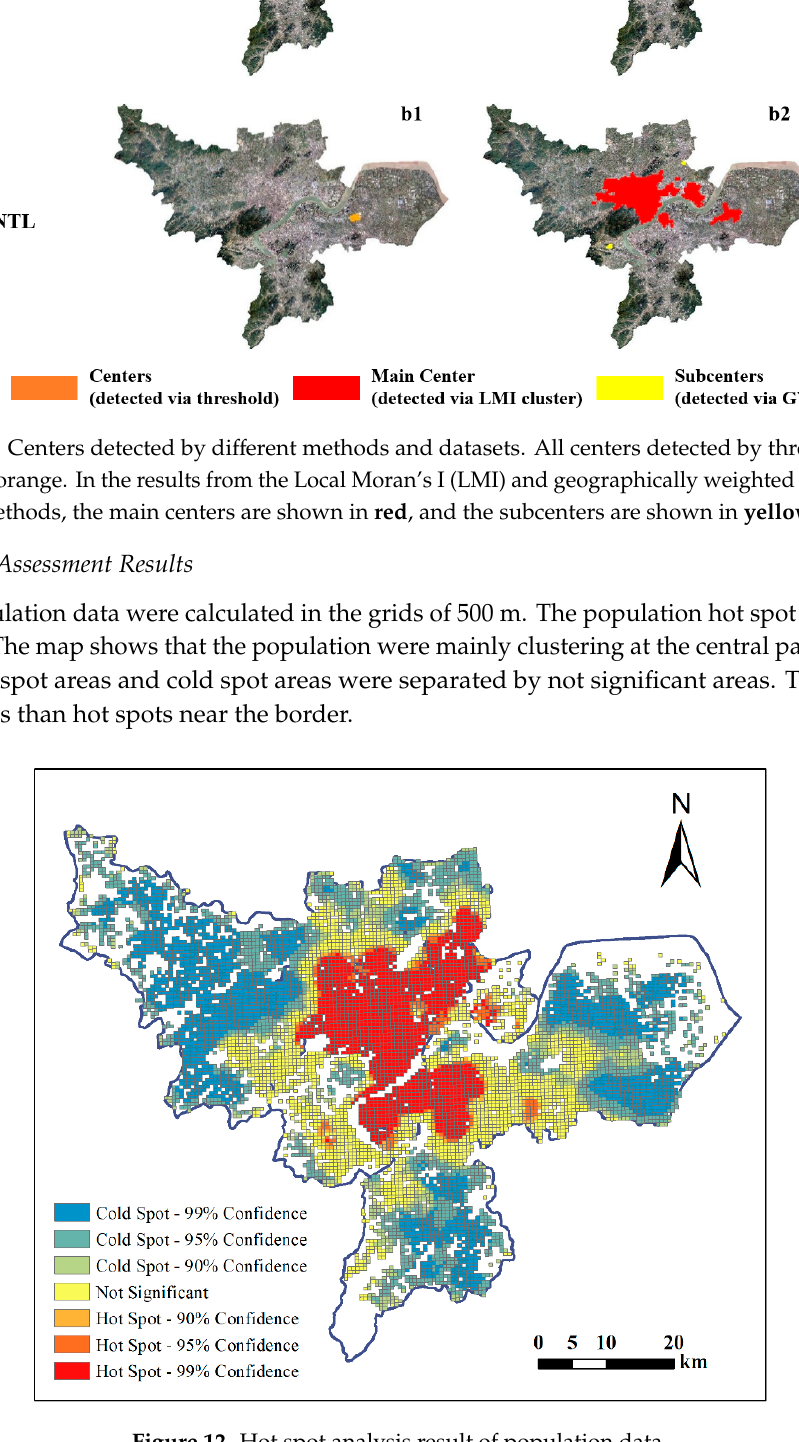
Figure 12. Hot spot analysis result of population data.